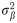
Proportion of narrow-sense chip heritability, A(N) (Eq 37), captured by genome-wide significant SNPs as a function of sample size, N, for phenotypes shown in Figs 1 and Fig 2.Values for current sample sizes are shown in parentheses. Left-to-right curve order is determined by decreasing σβ2. The prediction for education at sample size N = 1.1 million is A(N) = 0.27, so that the proportion of phenotypic variance explained is predicted to be 3.5%, in good agreement with 3.2% reported in [70]. (The curve for AD excludes the APOE locus. For HDL, see S1 Appendix (p. S9) for additional notes).